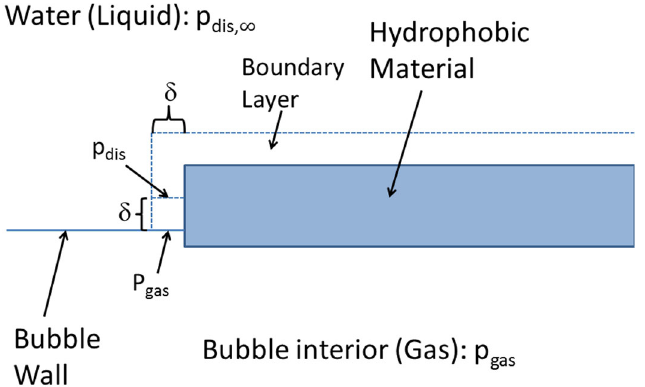
Figure 2. Enlarged view at around the bubble wall partly covered with hydrophobic material (im- purity). Reprinted with permission from Ref. [56]. Copyright 2016, the American Chemical Society.